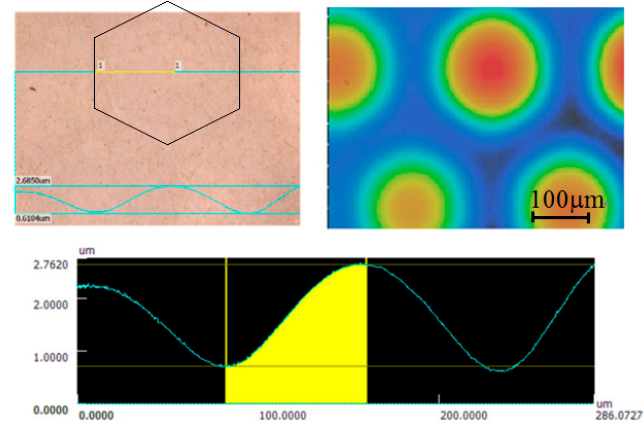
Figure 15. Swelling of the transparent CMUT membranes after 24 h of operation.